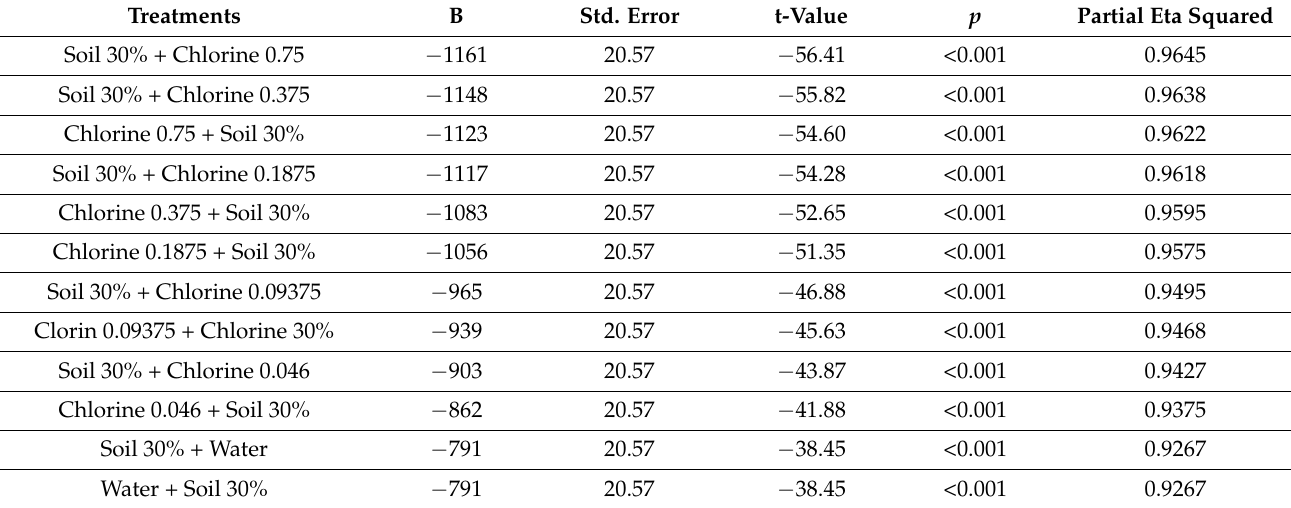
Table 3. Effect of various combination treatments on